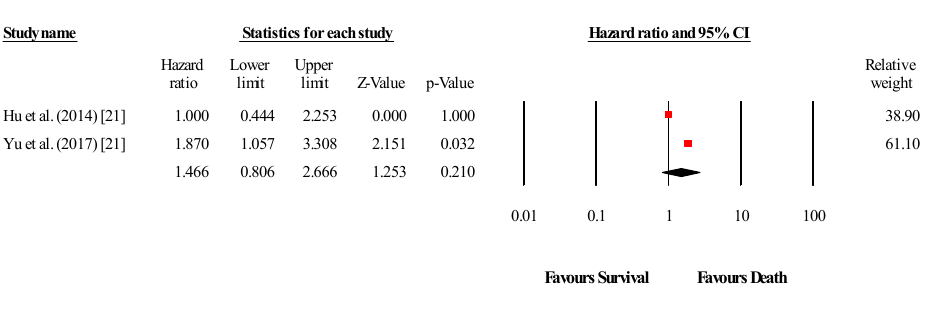
Figure 12. Forest plot for miR-21 association with DFS.